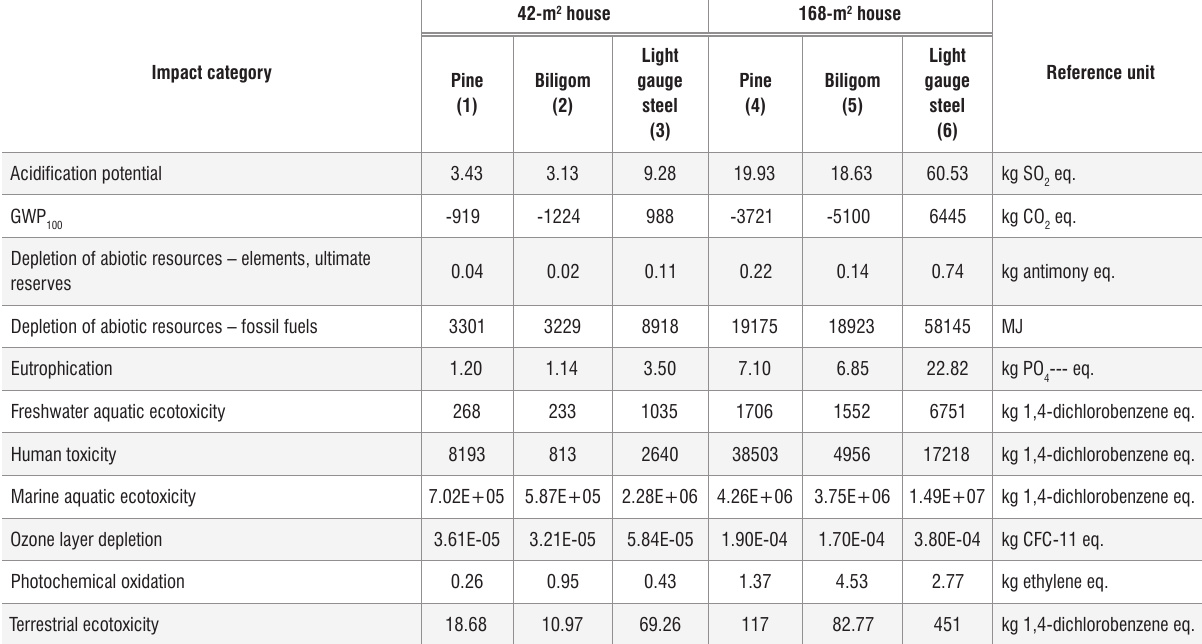
Cradle-to-gate roof truss alternative impact assessment summary for the two roof designs